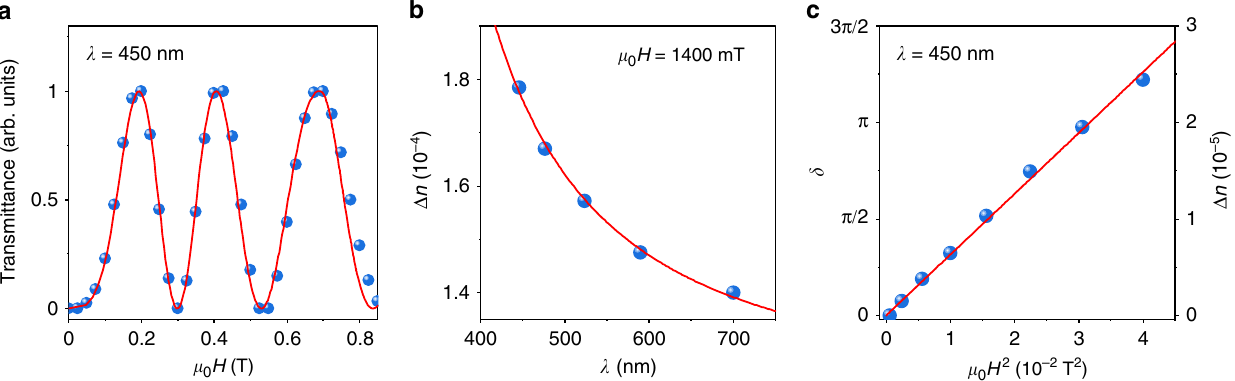
Fig. 4 Analysis of magnetic fi eld-induced birefringence of CTO suspensions. a Magnetic fi eld dependence of the light transmission for λ = 450 nm. Symbols: experimental data. The solid red curve is the best fi t using the model described in Supplementary Note 1. b Dispersion of the birefringence. Symbols show Δ n ( λ ) calculated using Δ n = λδ /2 π L , where each value of λ corresponds to either minimum or maximum transmission intensity measured at μ H = 1400 mT. Solid red line is a fi t to the wavelength dependence of Δ n derived in Supplementary Notes 1 and 3. c Magnetic- fi eld dependence of the 0 phase retardation and birefringence in the low- fi eld range, 0 – 200 mT. Symbols: experimental data; solid red line: linear fi t. Here, Δ n is calculated from the δ H ð Þ measured δ ( H ) for λ = 450 nm as Δ n H ð Þ ¼ λ 2 π L